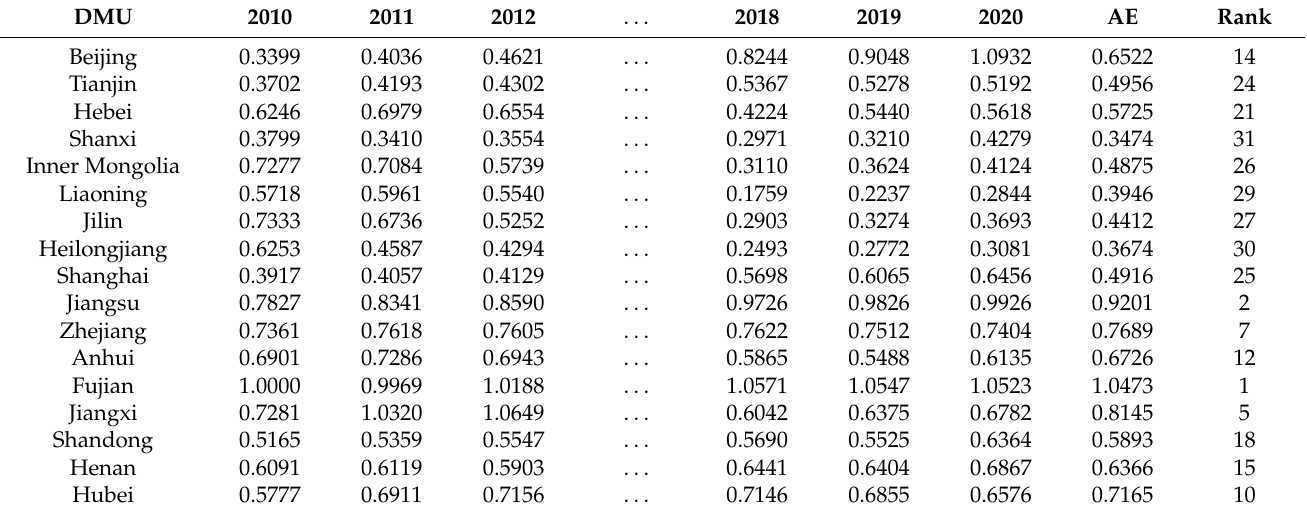
Table 6. CPE of the construction industry in 31